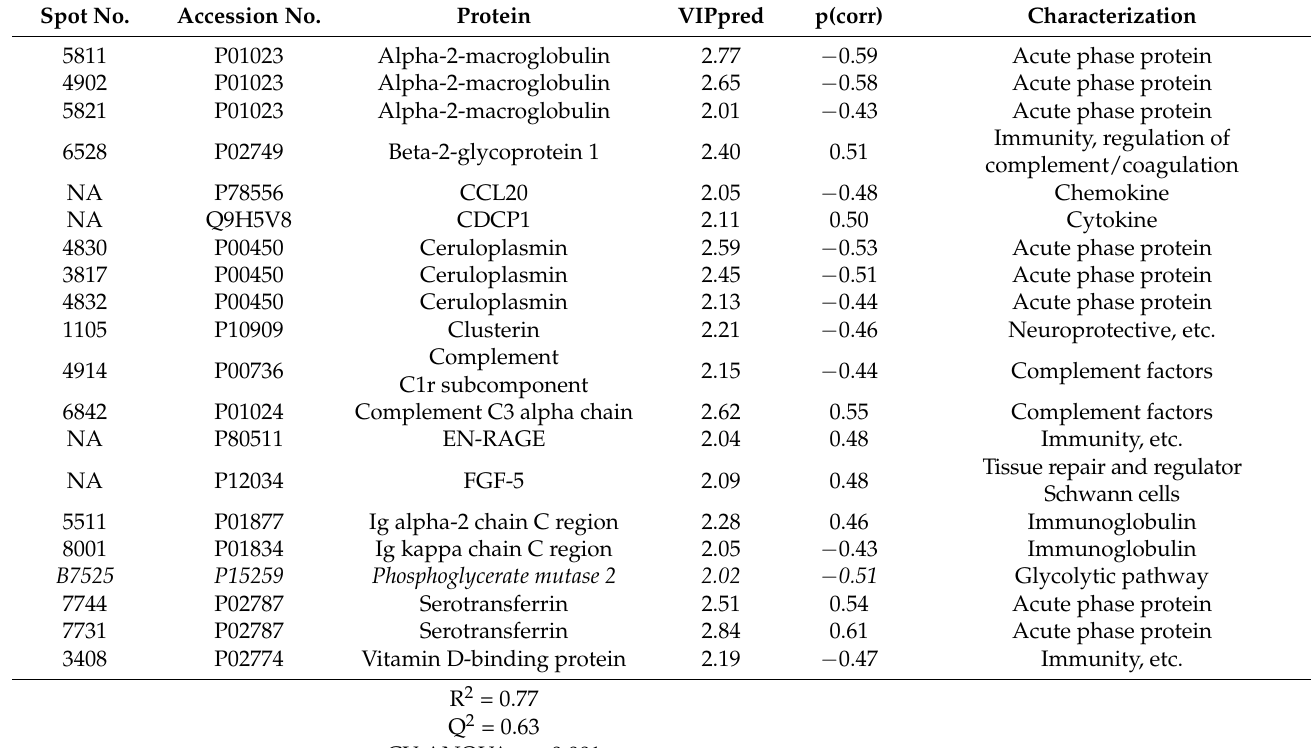
Table 4. OPLS regression of HPT in CON; significant proteins (in alphabetical order) are presented according to VIPpred. Characterization is based on brief reviews (Text S2). Proteins in italics are muscle proteins and the others are plasma proteins. A negative sign for p(corr) indicates that high level of the protein is associated with a low pain threshold for heat. Spot